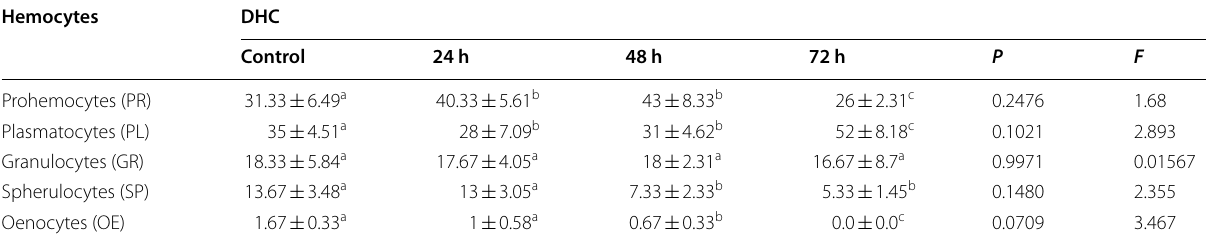
Means followed by the same letter in the same raw are not significantly different ( P > 0.05); n